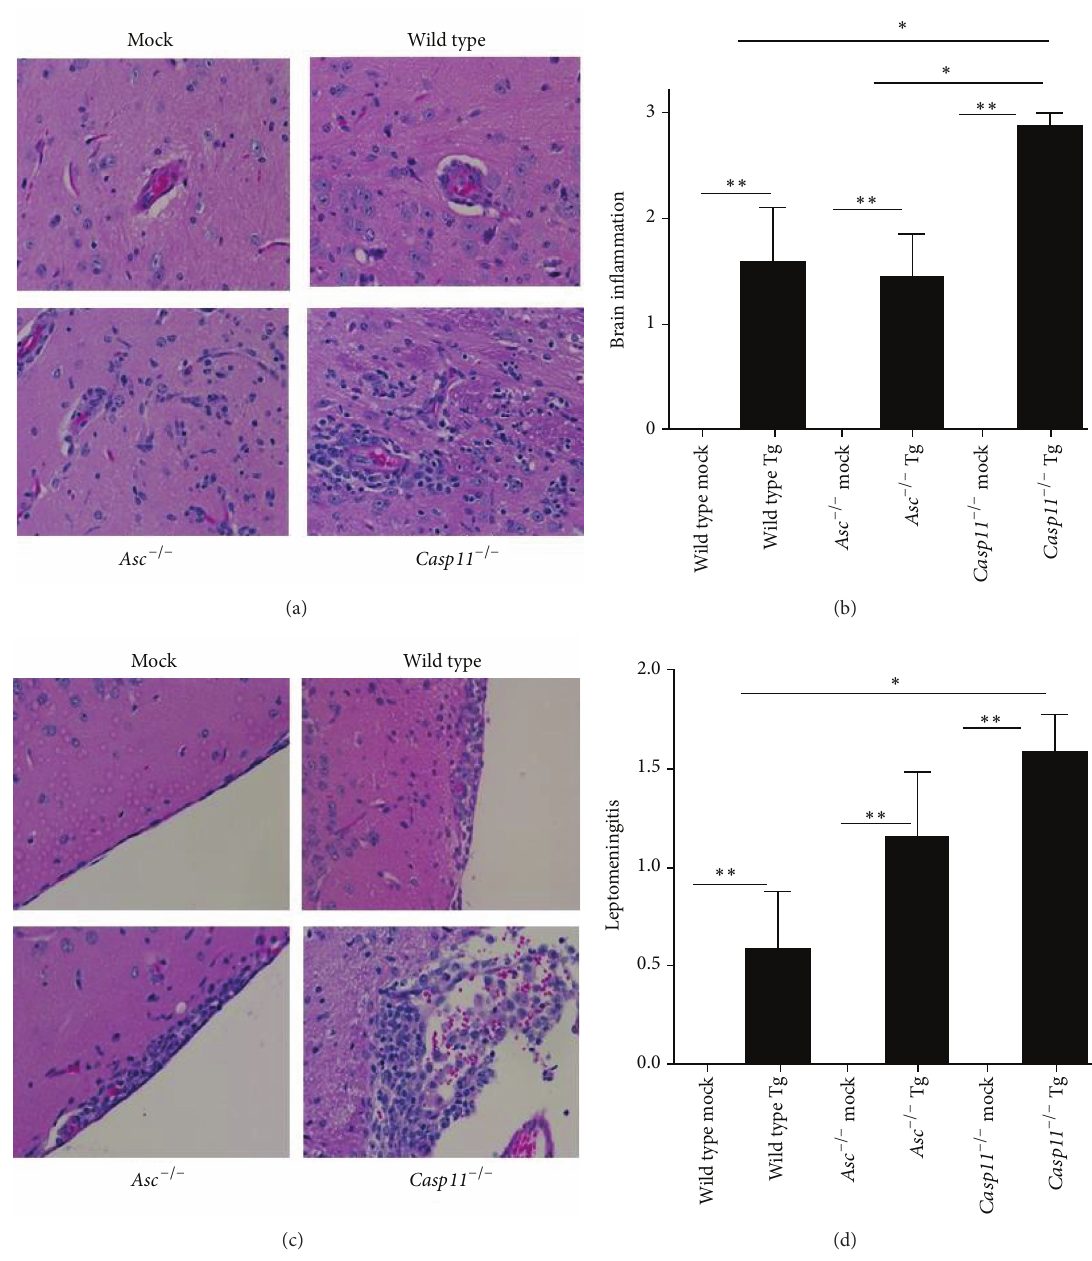
Figure 6: Toxoplasma gondii infection resulted in increased brain inflammation in Casp11 −/− mice during late stages of disease. Wild type, Casp11 −/− , and Asc −/− mice were infected with 1,000 Toxoplasma gondii Me49 tachyzoites via i.p. administration and brains were evaluated 25 days after inoculation in surviving mice. (a) Histopathologic assessments of H&E stained sections revealed increased inflammation in the brainsfromallanimalsinfectedwith T.gondii .20xmagnification.(b)Parametersassociatedwithneuroinflammationwereassessedandscored foreachanimal.Compositescoresforeachanimalwereaveragedtogenerateasemiquantitativebraininflammationscore.(c)Leptomeningitis was a predominate feature in all T. gondii infected animals. 20x magnification. (d) Histopathology scoring revealed significant increases in leptomeningitis in Casp11 −/− mice. ∗ 𝑝 < 0.05 ; ∗∗ 𝑝 < 0.01 . For all mock treated animals, 𝑛 = 3 . For all T. gondii inoculated animals, 𝑛 = 7 . Data shown are representative of 2 independent